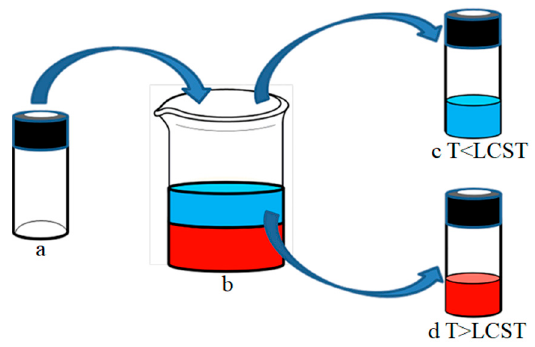
Figure 3. Simulation diagram of the oil–water separation process. ( a ) Perforated sample bottles sealed with copolymer-coated paper; ( b ) oil–water mixture; ( c ) deionized water was collected in the sample bottle when T < LCST ( d ) red n-hexane was collected in the sample bottle when T > LCST.